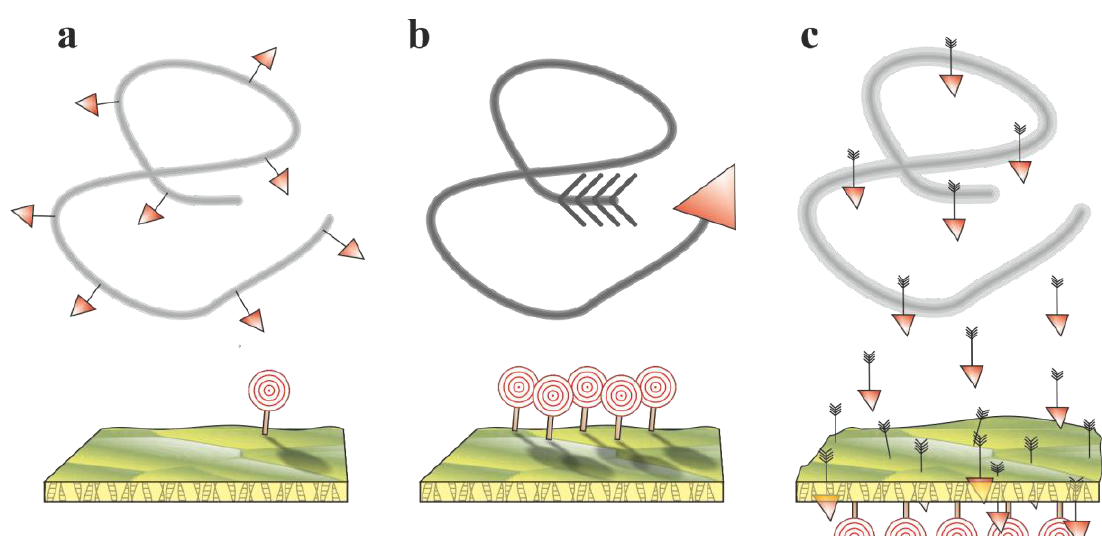
Figure 2. General working principles of antimicrobial polymers: ( a ) polymeric biocides; ( b ) biocidal polymers; ( c ) biocide-releasing